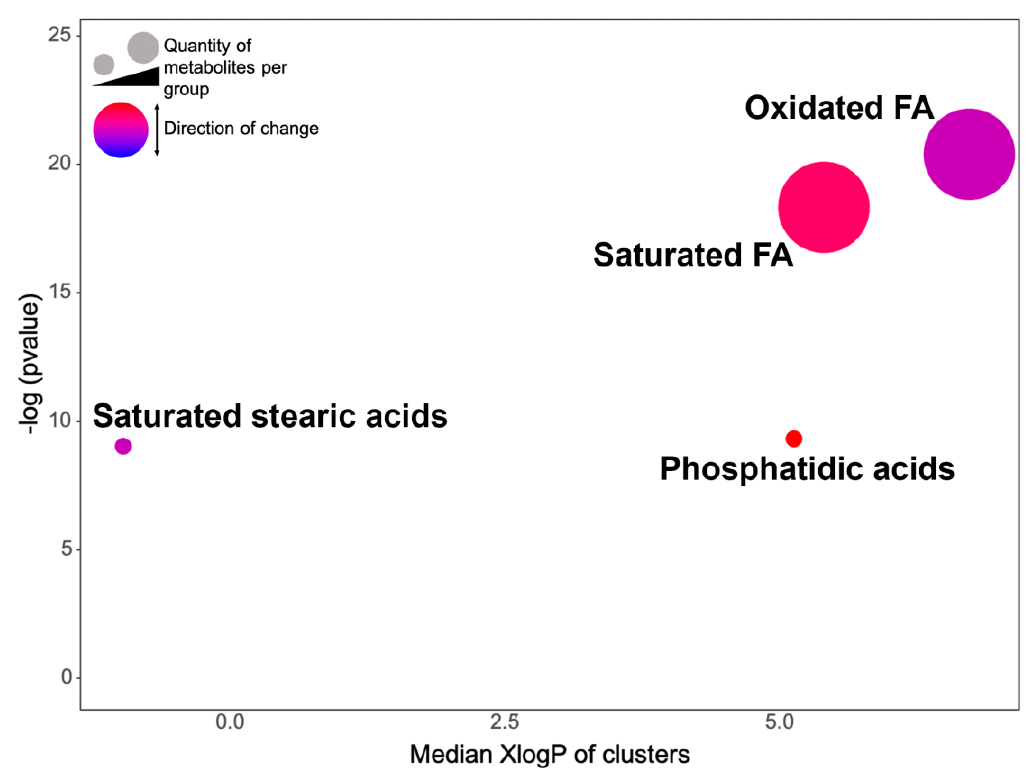
Figure 6. Chemical enrichment analysis of the dysregulated metabolites in planktonic cells by silver nanoparticles (AgNPs). Each node represents a significantly perturbed cluster of metabolites. Node sizes reflect the total number of compounds belonging to the chemical class. The node color scale shows the proportion of increased (red) or decreased (blue) compounds for each cluster. Different purple tones reflect the proportion of increased and decreased metabolites. p -values were calculated by the Kolmogorov – Smirnov test.